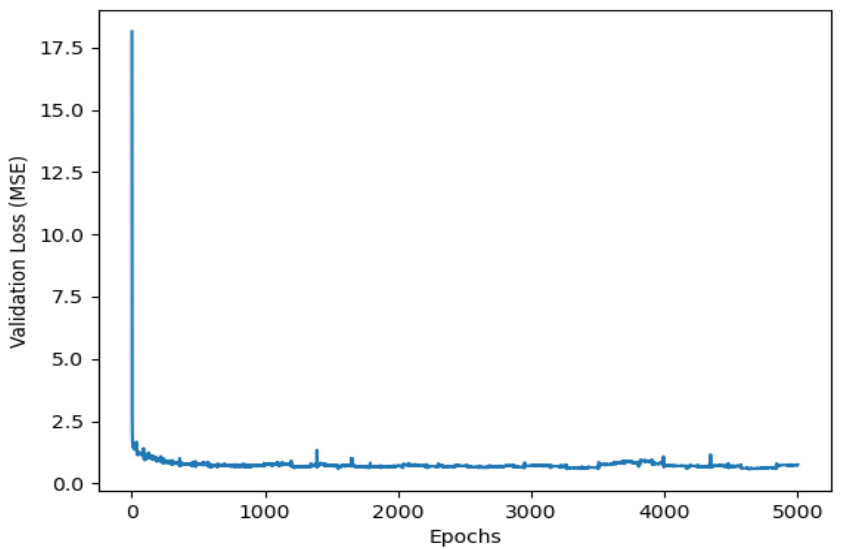
Figure 13. Average validation MSE in Four-fold cross-validation experiment for unimodal deep model.